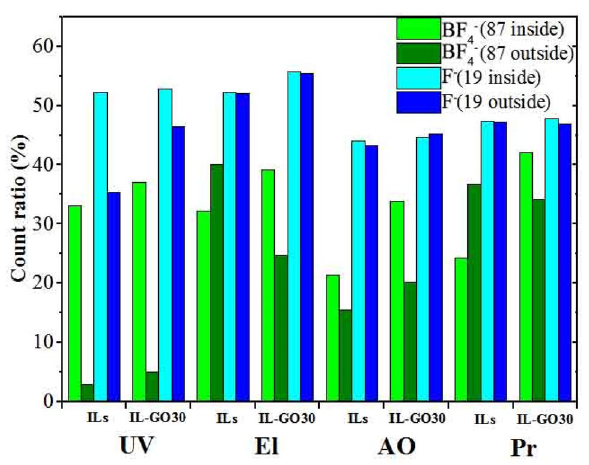
Figure 6. Count ratio obtained via the TOF-SIMS analysis using ILs and